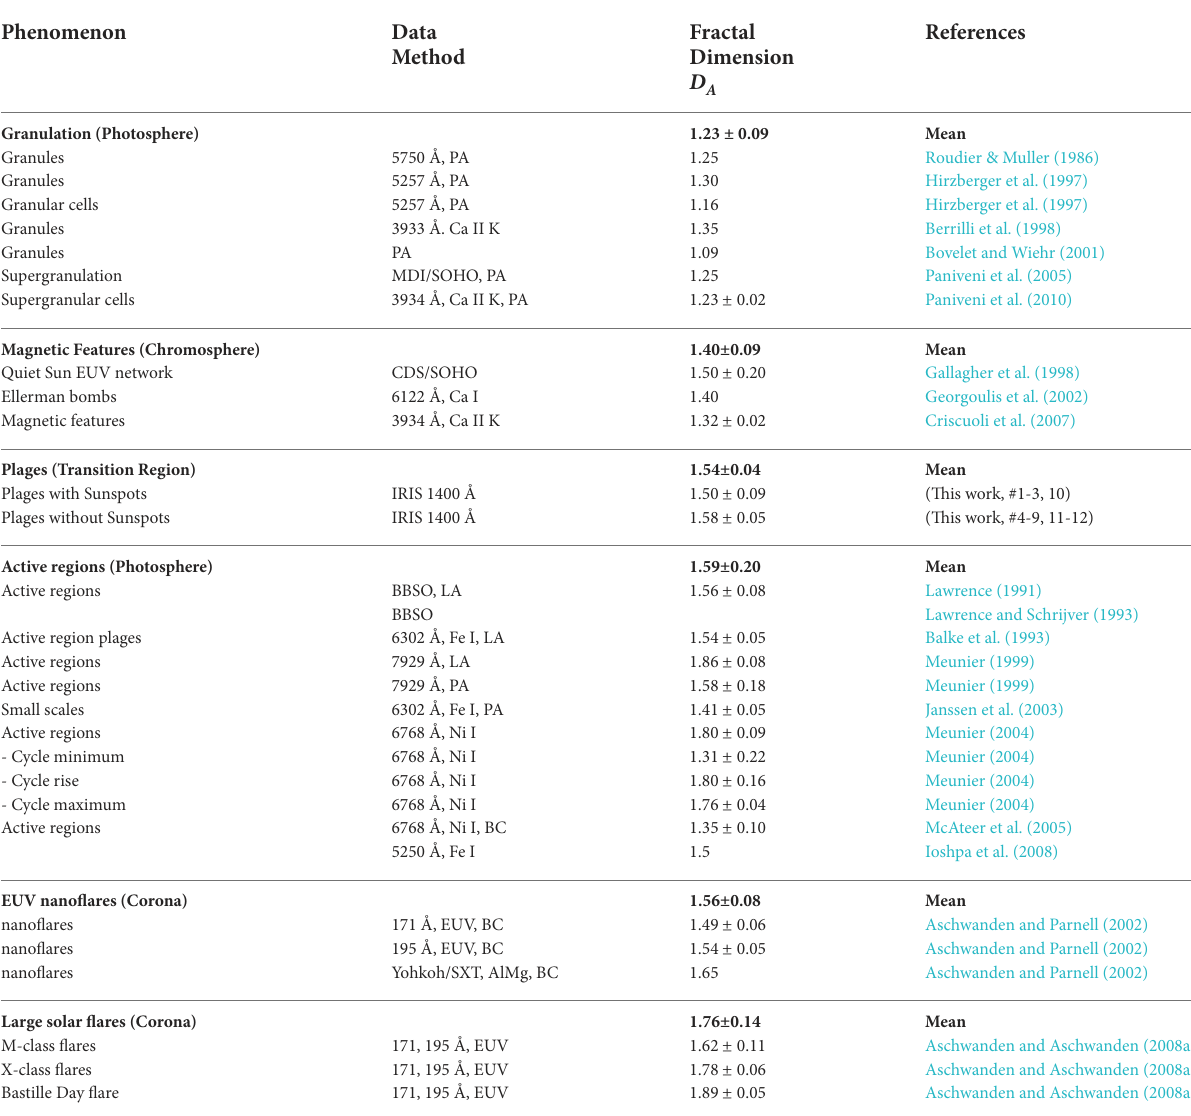
TABLE 3 Thefractaldimensionsofgranules,plages,activeregions,nanoflares,andlargeflares.Differentmethodsareindicatedwiththeacronyms(LA= Linear-area;PA=perimeter-area,andC=boxcounting.Meanvaluesandstandarddeviationsofeachgroupareindicatedwithboldnumbers.Studiesbased ontheCaIIKlineextendoverboththephotosphericandchromosphericzone.